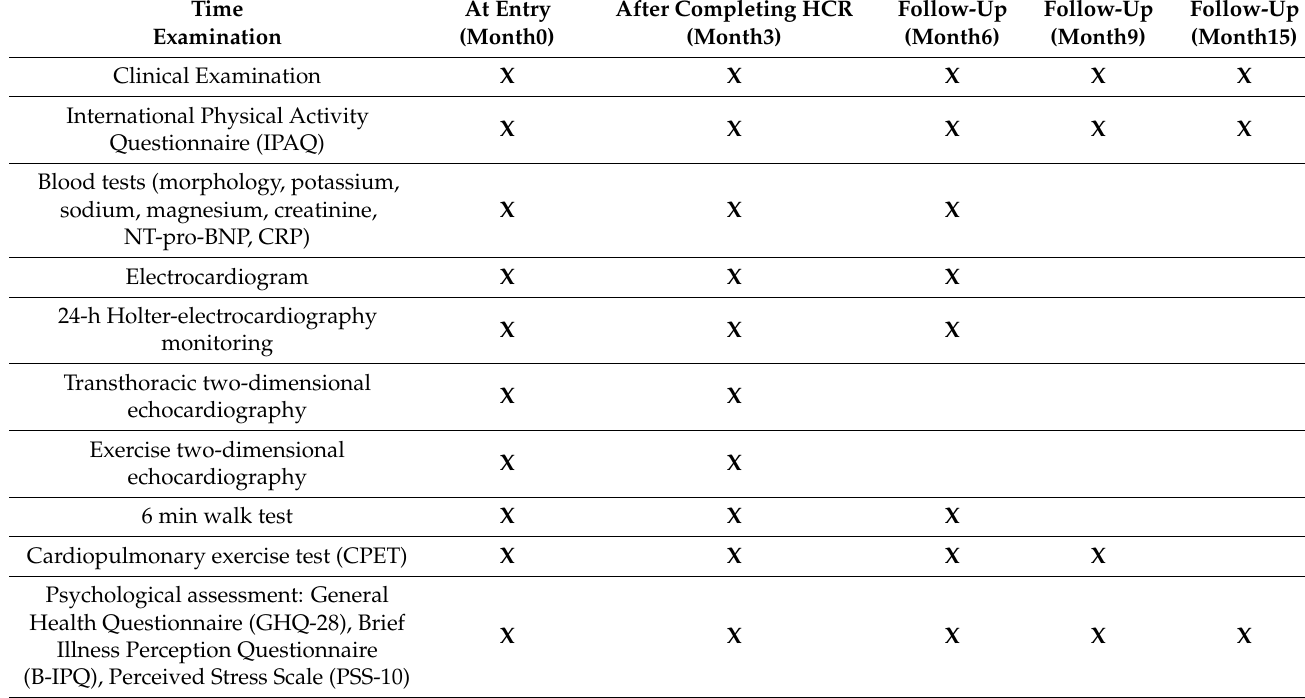
Table 3. Clinical examination and diagnostic